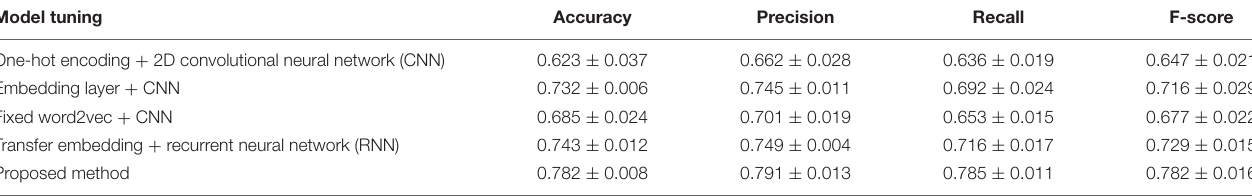
TABLE 2 | Cross validation performance comparison between different deep structures and feature encondings.